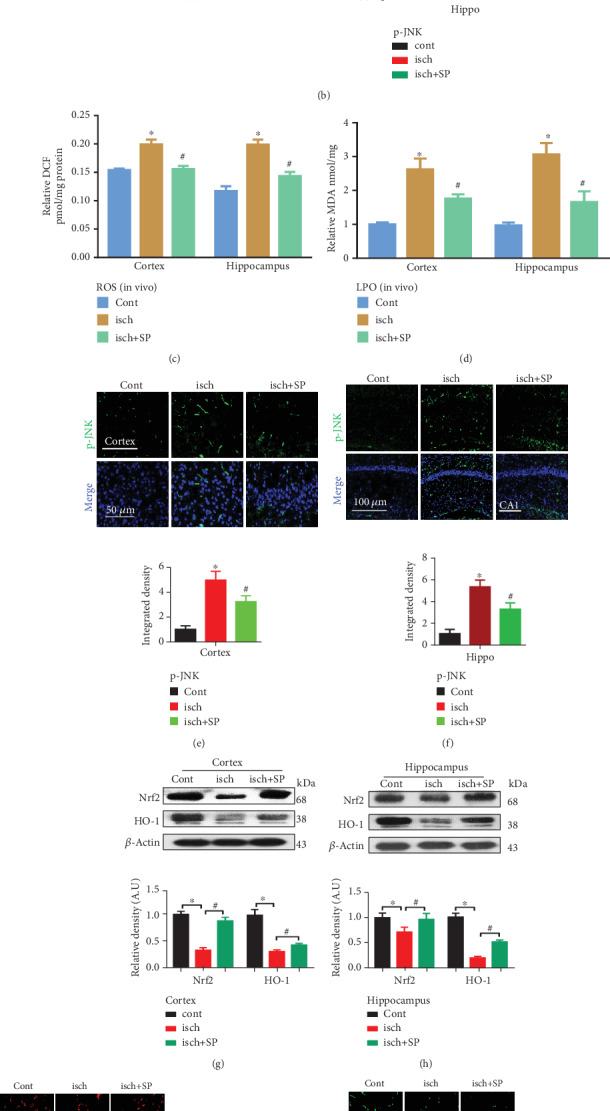
Chronic ischemia induced the stress kinase p-JNK activation and deregulates Nrf2/HO-1 proteins. (a, b) Western blot findings of p-JNK in the different samples of the experimental groups. (c, d) Showing ROS and LPO assay results. (e, f) Immunofluorescent images representing the immunoreactivity of p-JNK (FITC; green color, DAPI; blue color) both in the cortex and hippocampal regions. (g, h) Western blot results of Nrf2/HO1, in the cortex, and hippocampus of the experimental groups. (i, j) Immunofluorescence results of Nrf2/HO1 in the experimental groups. In confocal microscopy the Magnification were kept 10x, Scale bar = 50 μm for all antibodies. In western blot assay, the β-actin was used as a loading control. Density values are relative to the control group (Rounding Rules) and expressed in arbitrary units (A.U). For western blot. The data are presented as the mean ± SEM. ∗Significantly different from the control group; #Significantly different from the ischemia group. Significance =  ∗P < 0.05, #P < 0.05.